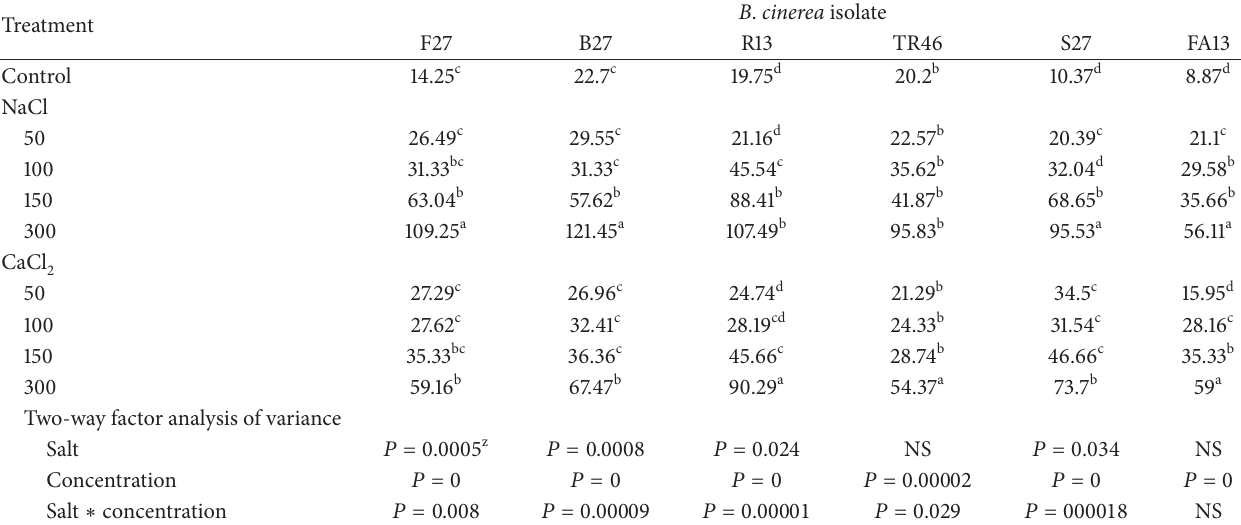
Table 2: Effect of different concentrations of NaCl and CaCl in potato dextrose agar (PDA) at 25 ∘